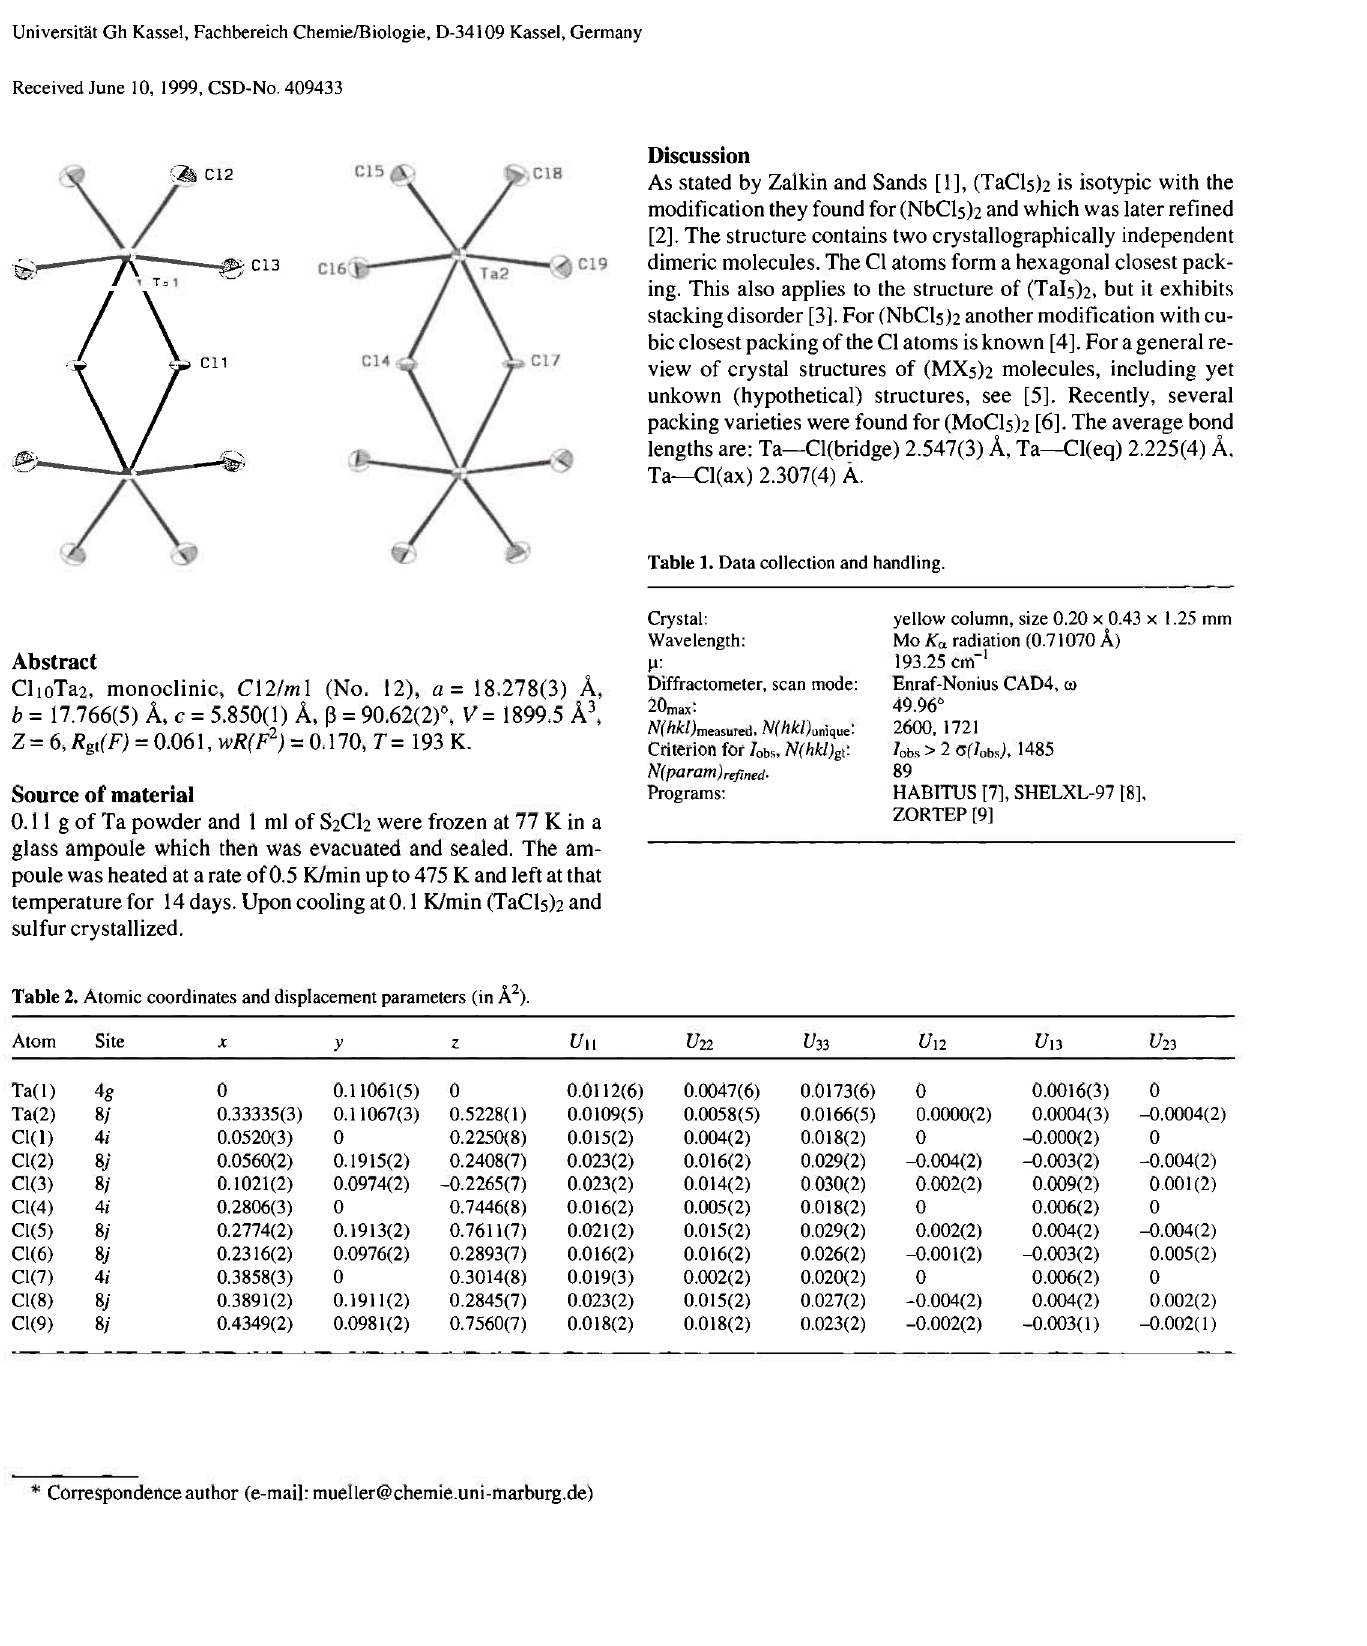
Z= 6, R s t(F) = 0.061, wR(F 2 ) = 0.170, T= 193 K.